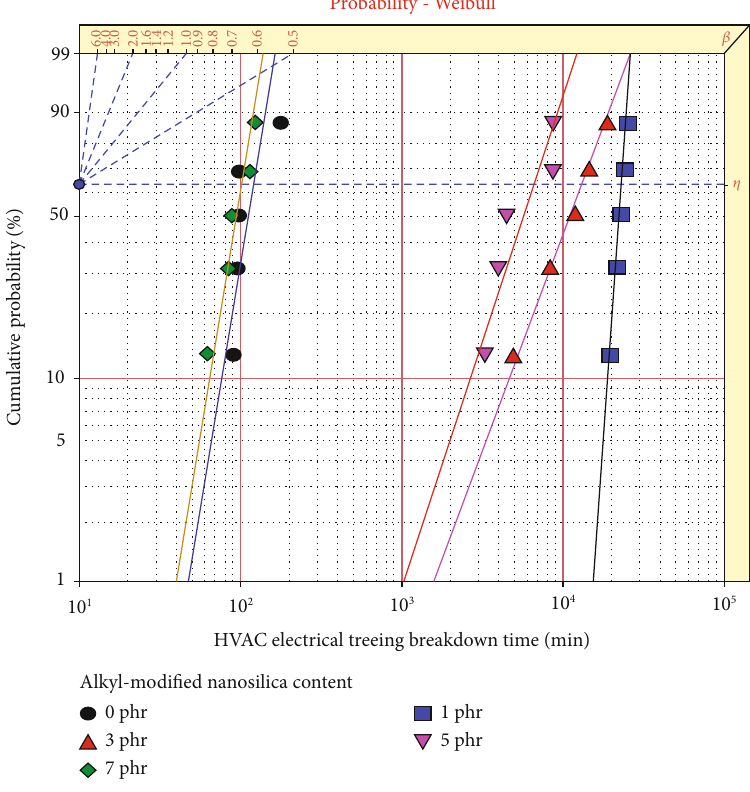
Figure 6: HVAC electrical treeing breakdown time for epoxy nanocomposites with di ff erent alkyl-modi fi ed nanosilica contents. Table 1: Weibull parameters of HVAC treeing breakdown time for epoxy